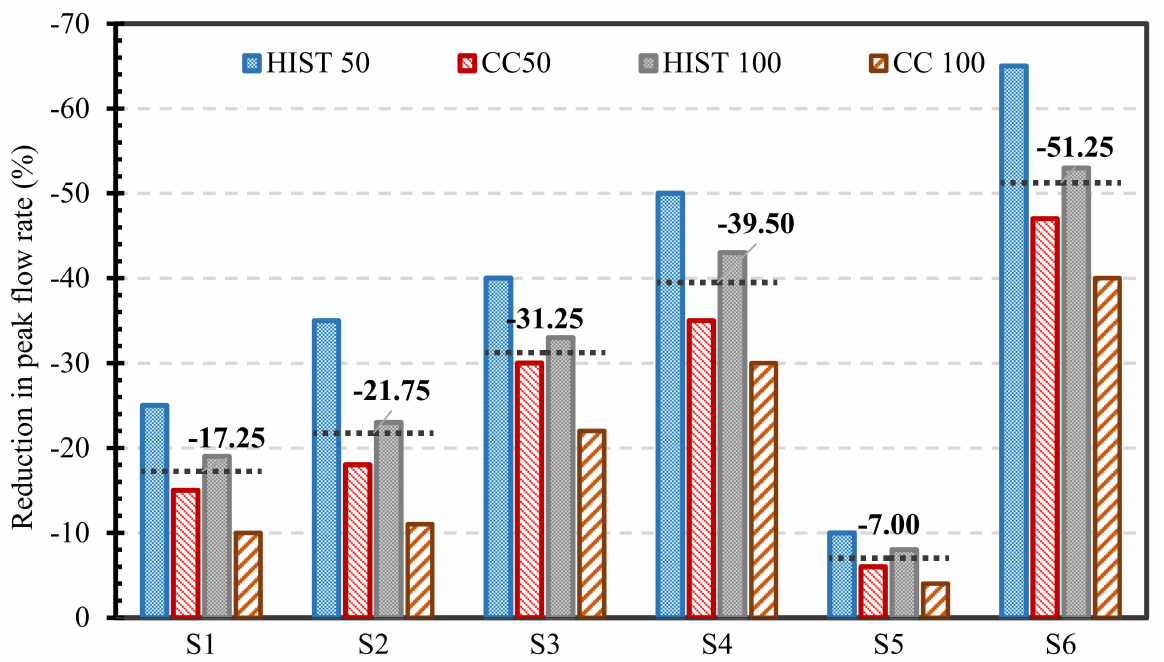
Figure 13. Reduction of peak flows (%) for different LIDs scenarios for 50- and 100-year storm events of the historical (HIST) and future periods (CC). Dotted lines represent the reduction of flow averaged over selected historical and future design